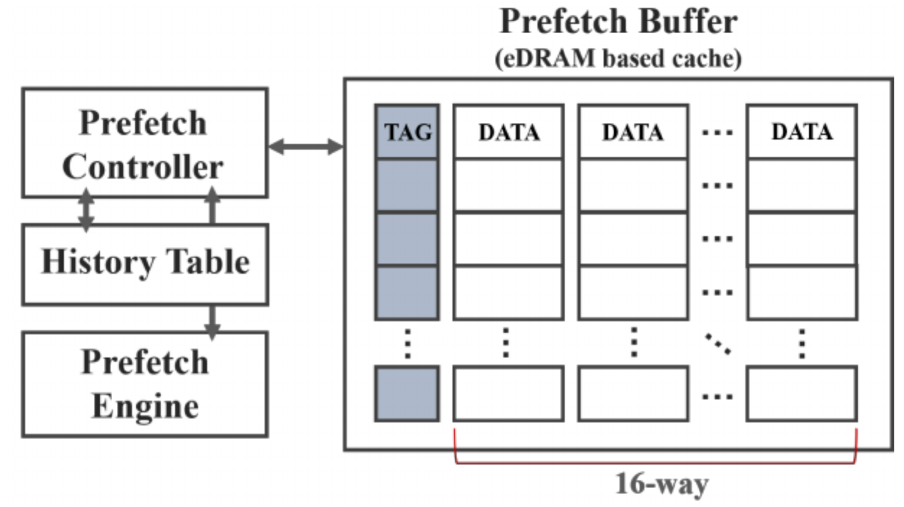
Figure 7. Internal structure of Prefetch